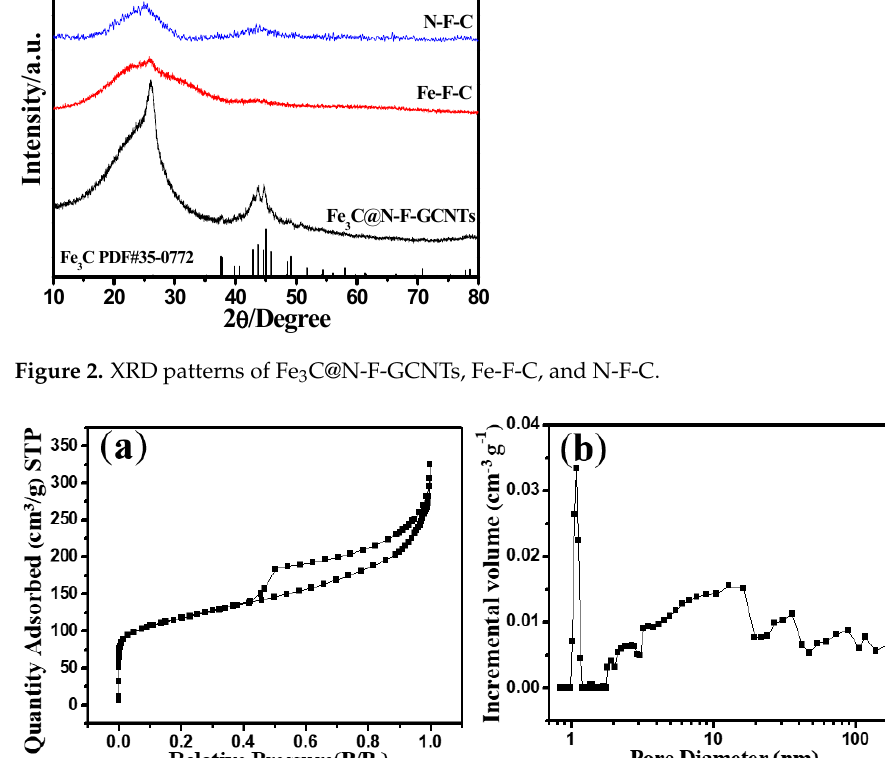
Figure 3. Nitrogen adsorption–desorption isotherms ( a ) and the corresponding pore-size distribution curve ( b ) of Fe 3 C@N-F-GCNTs.